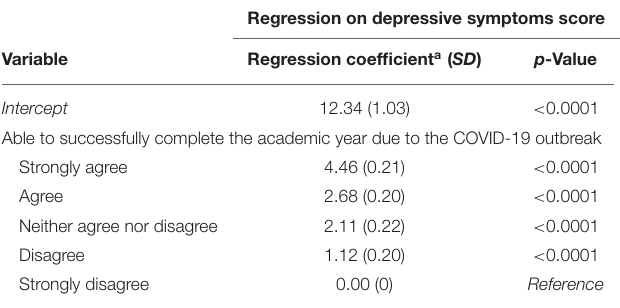
TABLE 6 | Effect estimates of the generalized linear regression model of confidence in completing the semester on depressive